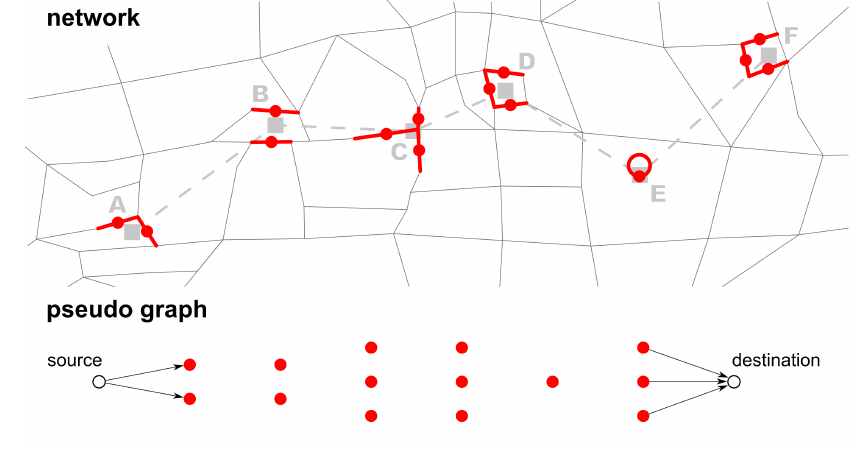
Figure 3. Each link candidate (red) is represented as a node in the pseudo